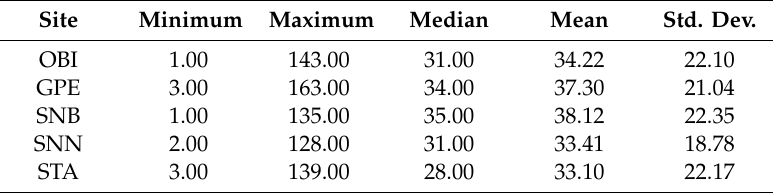
Table 5. Summary measures for observed O 3 maxima